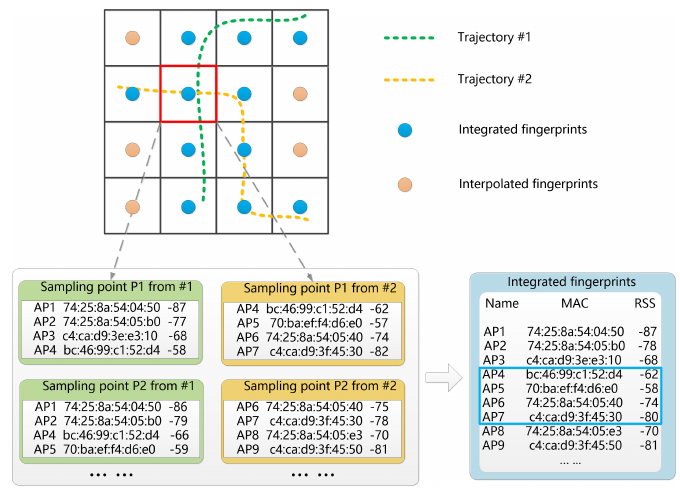
Figure 4. Integration of Wi-Fi APs for a